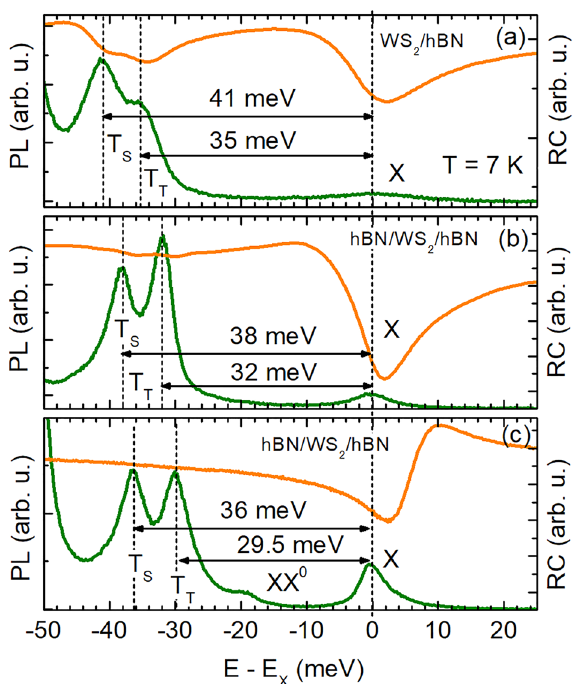
Figure 1. PL (green curves) and RC (orange curves) spectra of different vdW heterostructures assembled from a WS 2 monolayer and hBN layers, measured at 7 K. ( a ) s 1 -WS 2 /hBN with d = 240 nm, ( b ) s 2 -hBN/WS 2 / hBN with d = 15 nm and ( c ) s 3 -hBN/WS 2 /hBN with d = 240 nm. The energy differences between the neutral exciton and the singlet and triplet trion PL lines are indicated in each